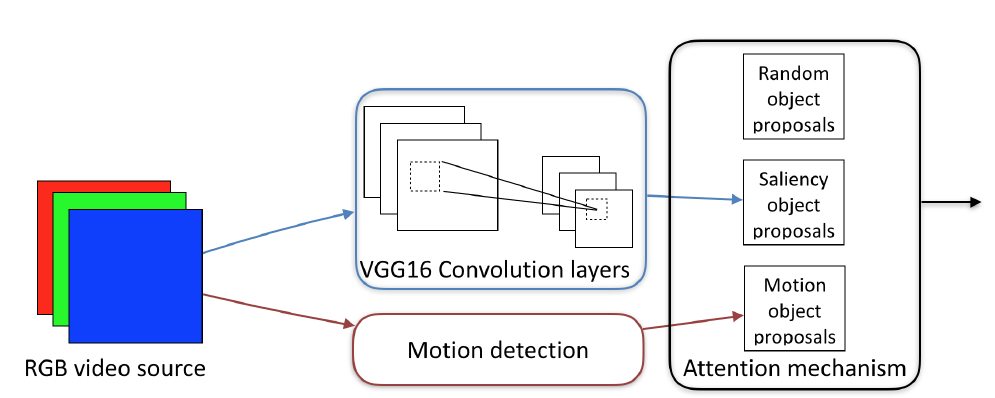
Figure 4. Schematic illustration of the VAP model attention